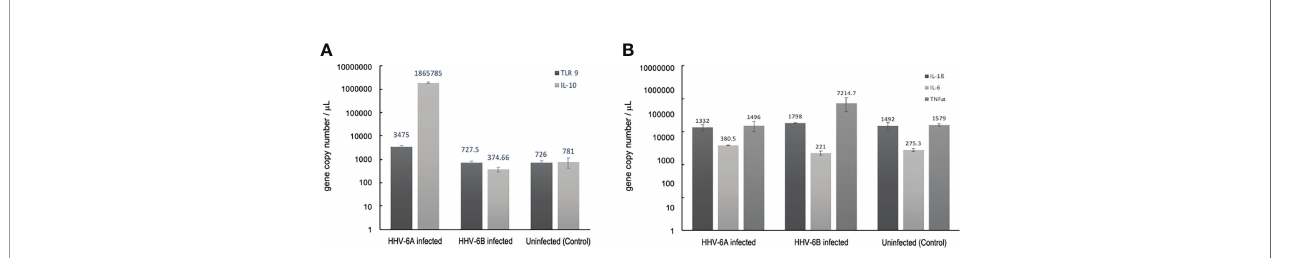
FIGURE 13 | Cellular cytokine responses to HHV6 infection in dHNSCs via RT-qPCR. (A) TLR9 gene expression levels (i.e., mRNA) are elevate in HHV-6A infected cultures;(N=3, p=0.0150) while no signi fi cant increase in TLR9 gene expression in HHV-6B infected dHNSCs when compared to uninfected controls ( dark grey ). Likewise, a signi fi cant increase in IL-10 is observed in HHV-6A infected cultures;(N=3, p=0.0029), while no signi fi cant increase in IL-10 gene expression is observed in HHV-6B infected dHNSCs ( light grey ). (B) Gene expression levels of IL-6 are slightly elevated in HHV-6 infected cultures ( light grey ), while no signi fi cant difference in IL-6 expression in HHV-6B infected dHNSCs is observed as compared to uninfected controls. TNF a expression is elevated in HHV-6B infected dHNSCs. No signi fi cant difference is observed in HHV-6A infected cells when compared to uninfected controls ( medium grey ). No change in IL-1 b is noted for either HHV-6A or HHV-6B infected cells ( dark grey ).